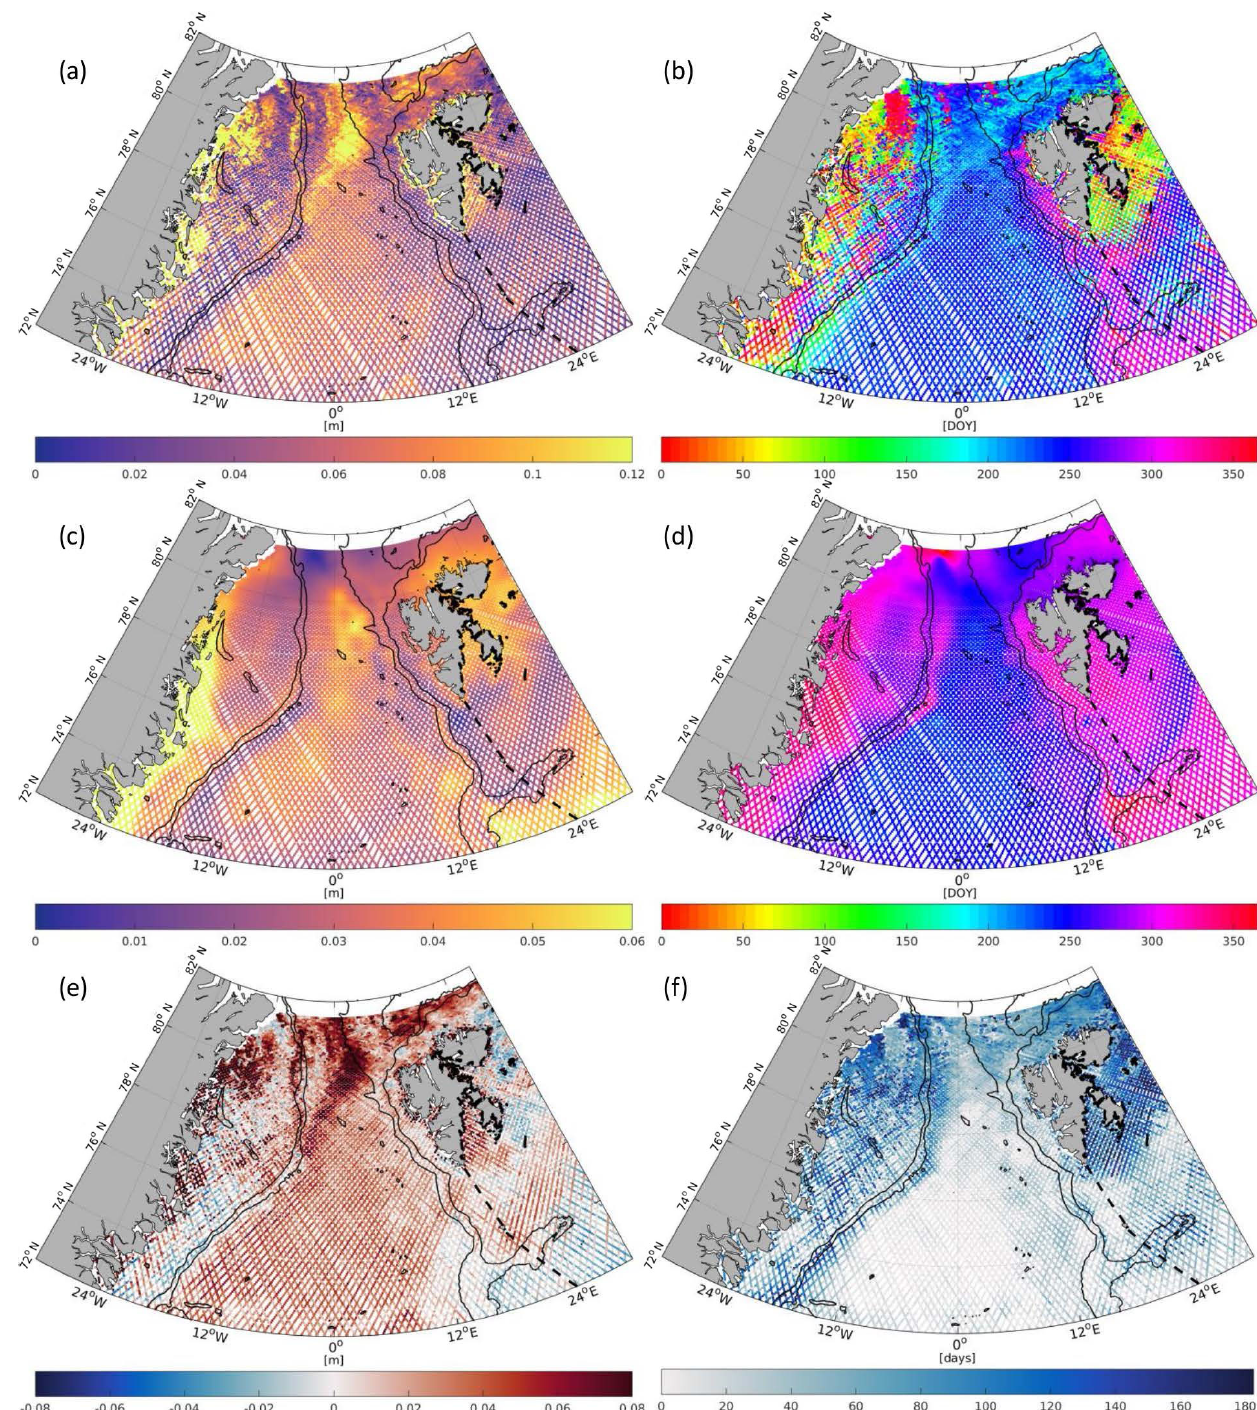
Figure 6. Mean annual amplitudes (a, c, e) and the day of year (DOY) of the annual maximum (b, d, f) per bin for altimetry (a, b) and FESOM (c, d) DOT heights. The bottom row (e, f) displays amplitude (in m) and phase differences (in days) of altimetry minus FESOM. RTopo2 bathymetric contours (black) indicate the shelf ( − 450m) and the basin ( − 1500m) regions. The dashed lines highlight the Barents Sea boundary (IHO, International Hydrographic Organization, 1953). Note the different scales of the amplitude color bars.